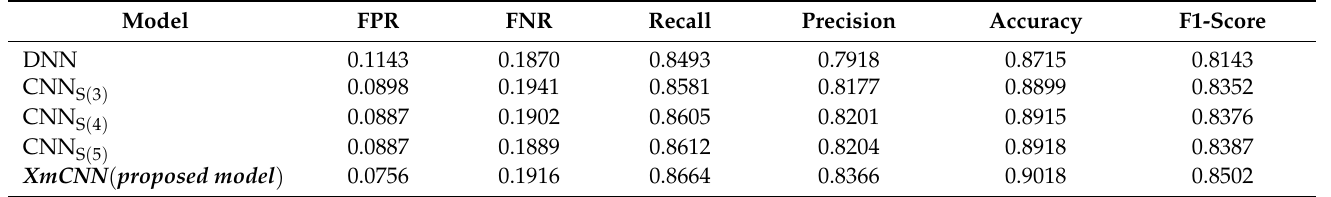
Table 8. Performance evaluation of deep learning